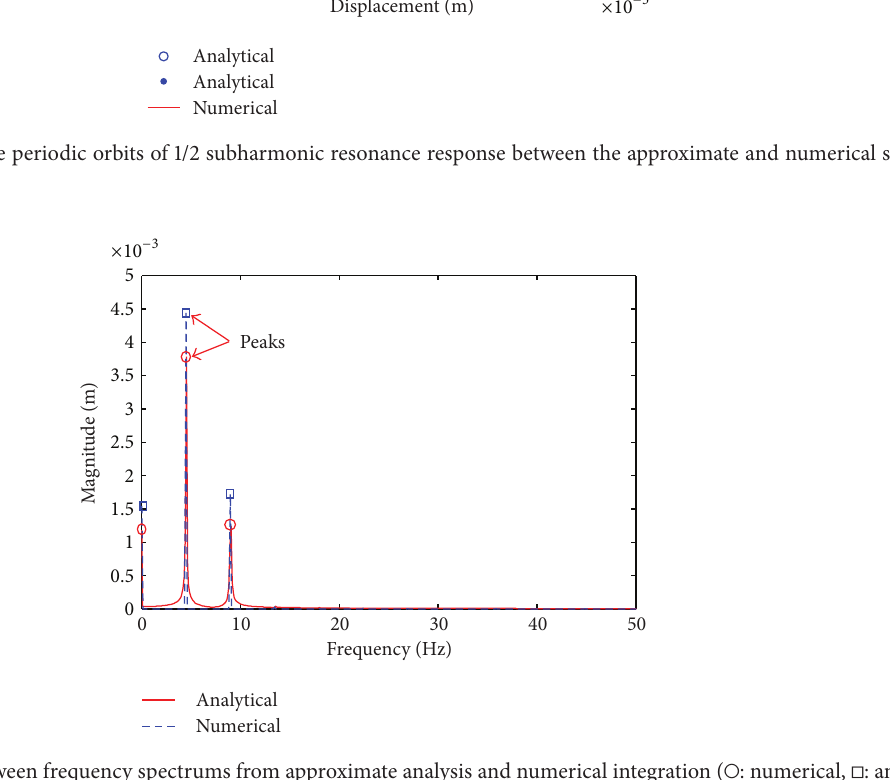
Figure 9: Comparison between frequency spectrums from approximate analysis and numerical integration ( I : numerical, ◻ :